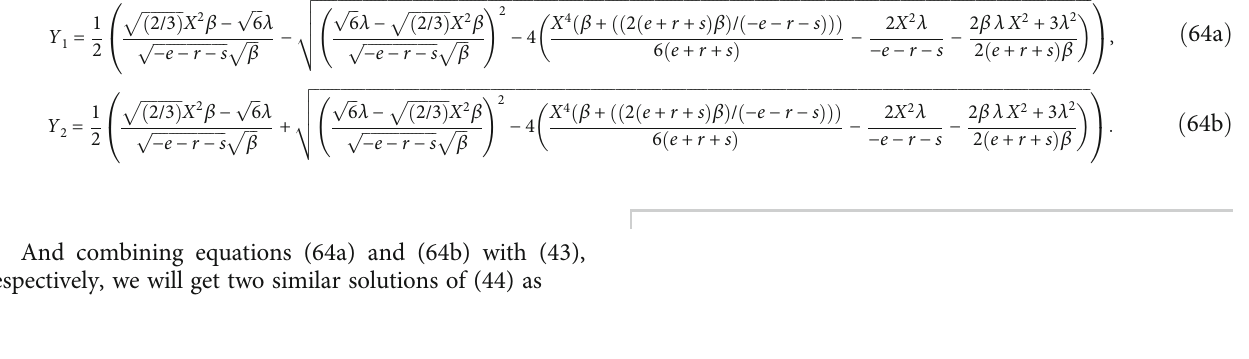
ffiffiffi p ffiffiffiffiffiffiffiffiffiffiffiffiffiffiffiffiffiffi − e − r − s p 2